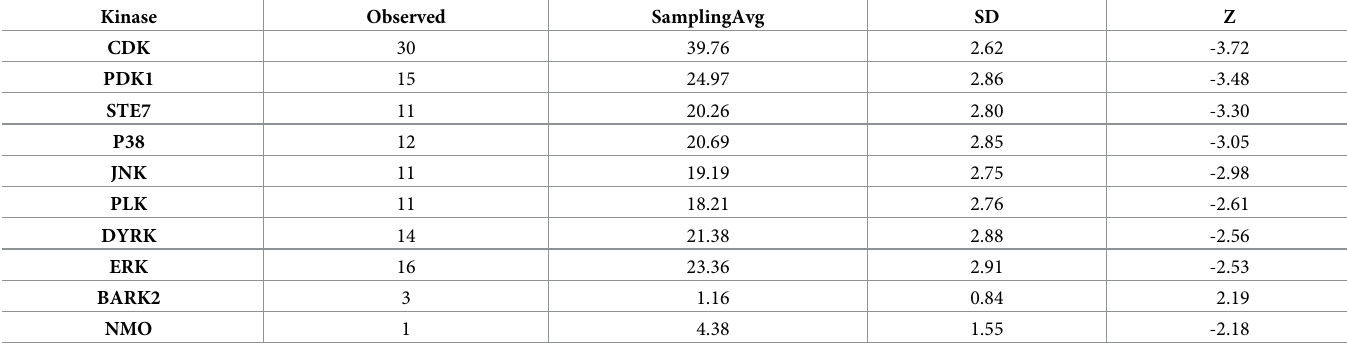
Table 1. Predicted kinases and distributions for female vs. male (DLPFC).